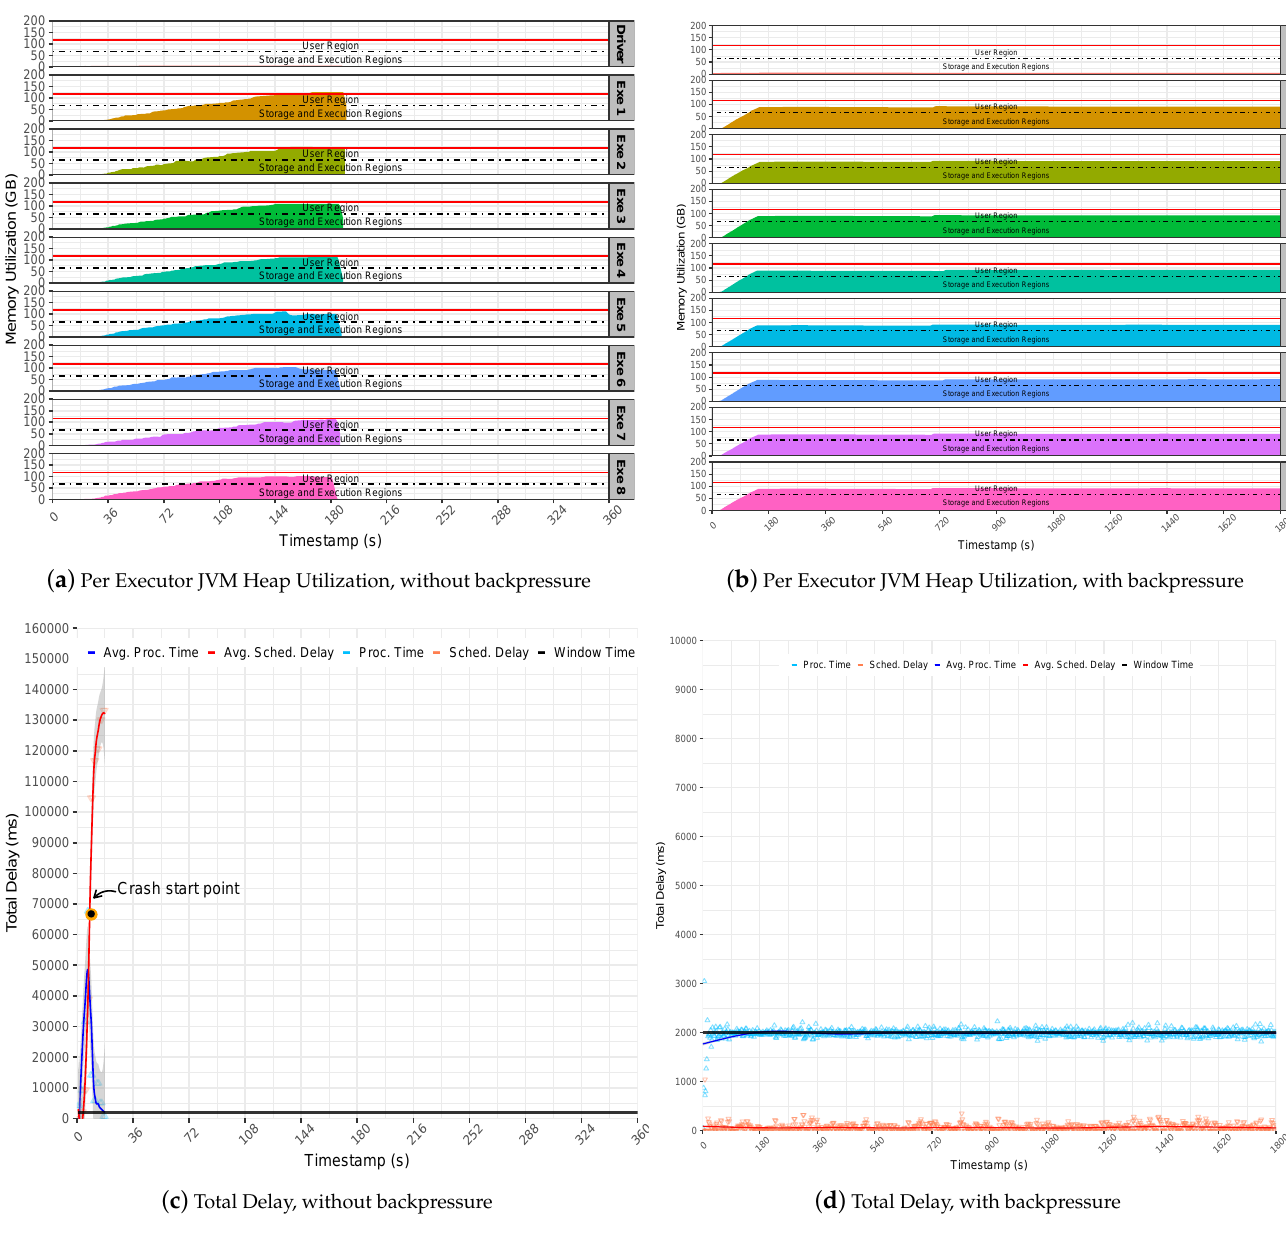
Figure 5. Stateless SumServer Application-Pipeline 2-Parasilo Cluster. The experiments in Pipeline 1 demonstrate how simple changes in the application life cycle may affect the overall SP pipeline performance. Figure 6a presents a regular use of the JVM heap memory in the Parasilo cluster. It demonstrates that almost 50% of allocated heap memory is free to be used for Executors and Driver instances. This occurs because Spark completely takes the incoming data, and there are no data being cached in heap memory, leading to a regular and stable use of the heap memory. The PT and SD reinforce this assumption since the metrics were intensive at the beginning due to high data ingestion but steady when data processing was faster than data sending to the MQs. In this case, the PT stabilized below the defined time window (1585 ms on average), and the SD did not present any intrusiveness (519 ms on average), indicating an under utilization of resources; see Figure